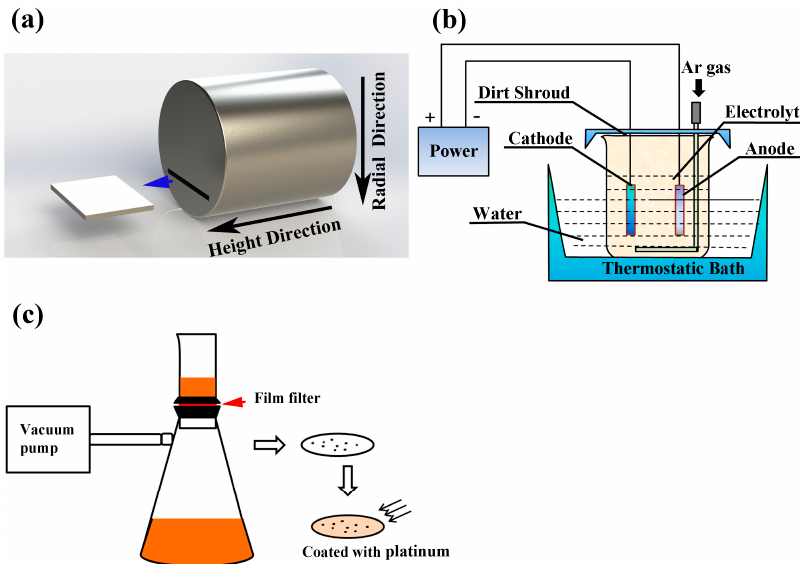
Figure 2. ( a ) Sheet cut from the ingot at the halfway point of the radius (“Height direction” and “Radial direction” are the vertical and horizontal directions of the RH ladle, respectively). ( b ) Schematic of non-aqueous solution electrolysis of a steel sample. The anode is a sheet cutting from the sample and the cathode is a platinum plate. ( c ) Collection of inclusions separated by vacuum filtration.